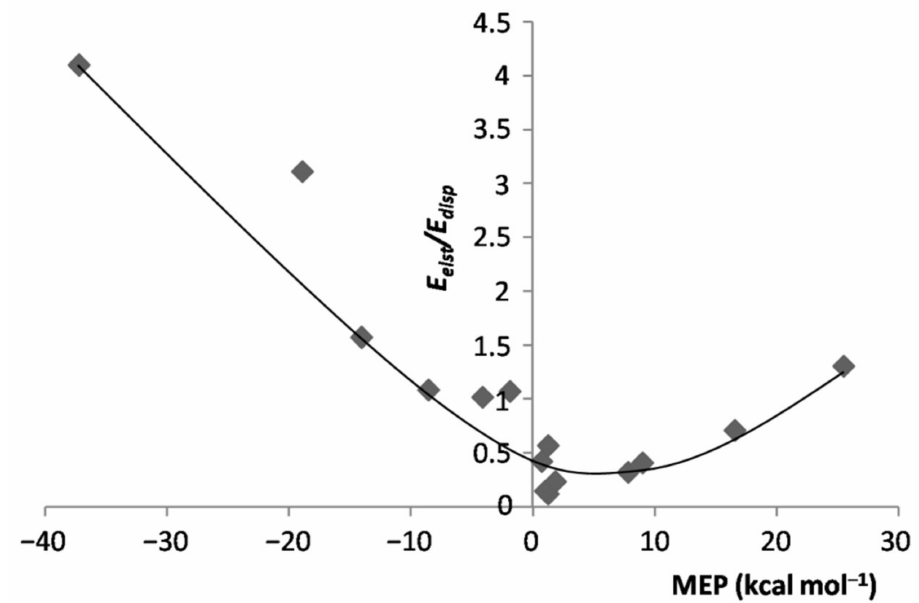
Figure 8. E elst / E disp ratio of the L -ArBeOvs. MEP at the V S,max / V S,min of L